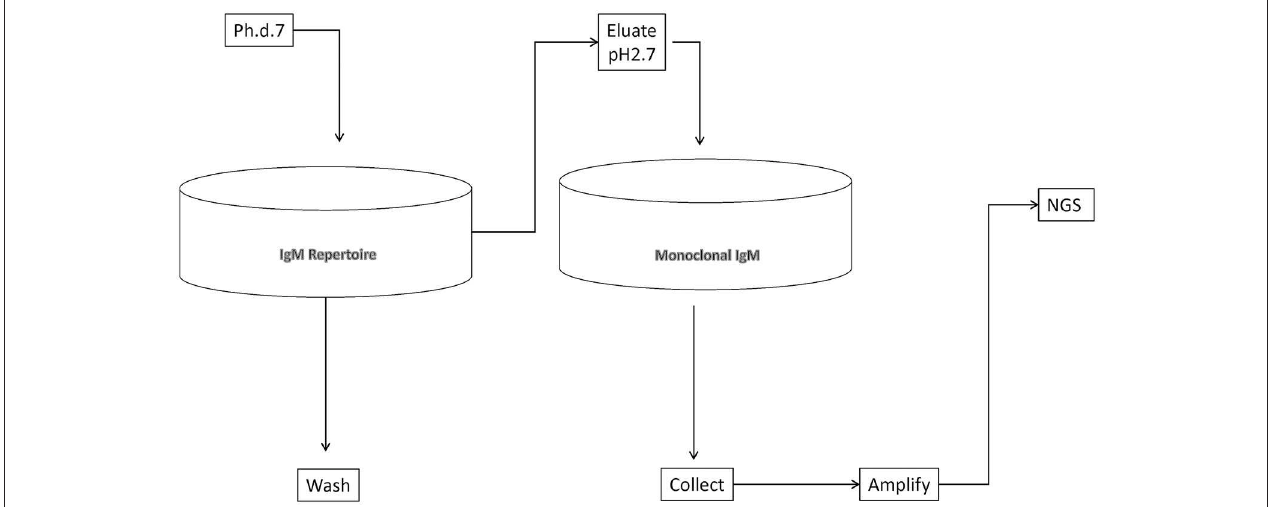
FIGURE 1 | Schematic representation of the deep panning experiment.